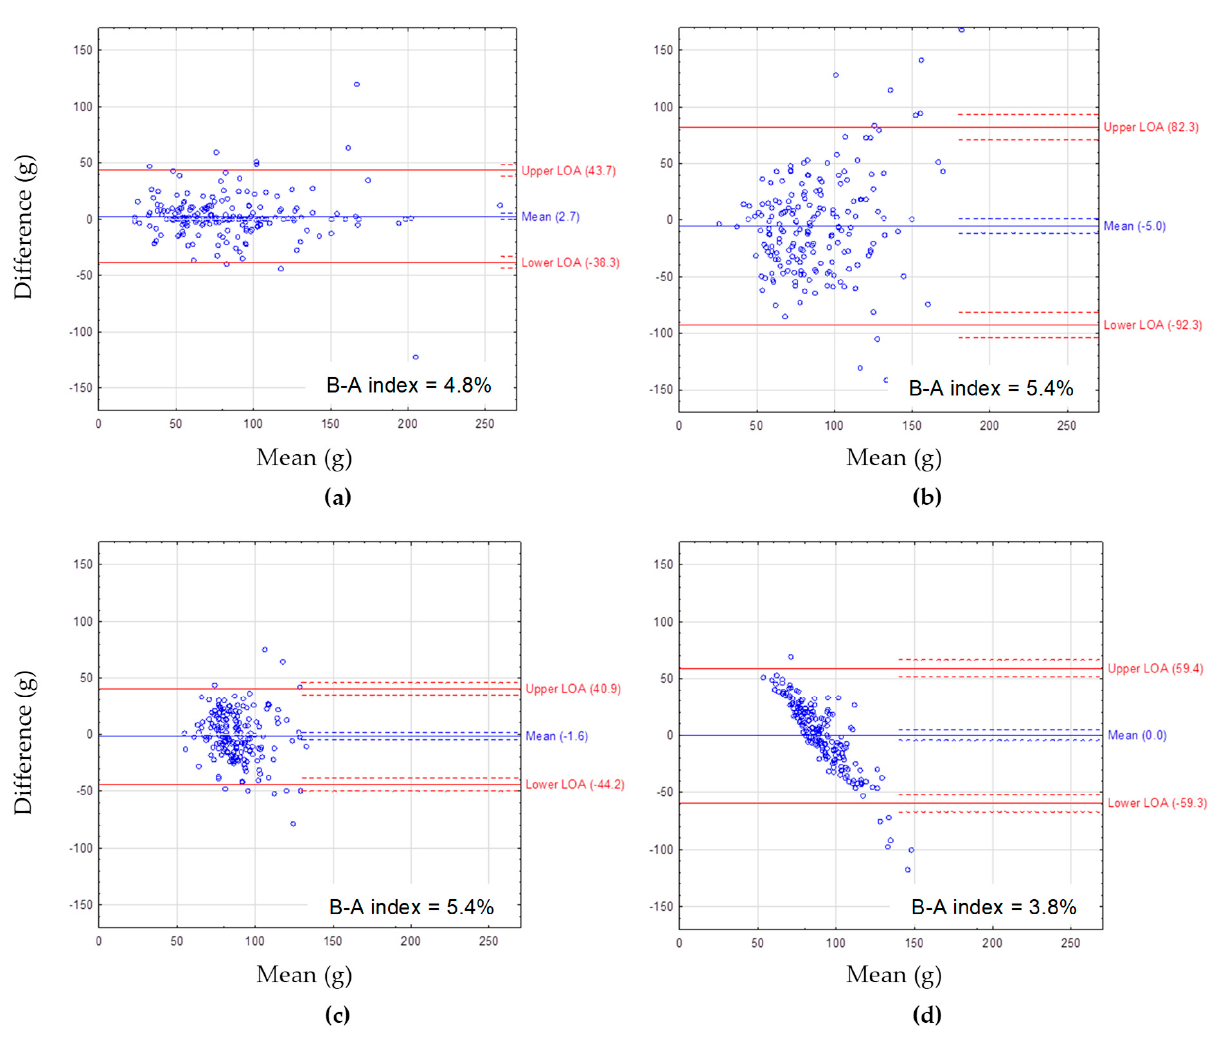
Figure 1. The Bland–Altman plots for protein intake assessed with: ( a ) FFQcrude and FFQretest, ( b ) FFQcrude and FRcrude, ( c ) FFQstand and FRstand, ( d ) FFQreg and FRcrude. FFQcrude—crude data from the first administration of the FFQ (test), FFQretest—crude data from the second administration of the FFQ, FRcrude—crude data from the 2-day estimated food record (FR), FRstand—the FR data after standardization of energy intake, FFQstand—the FFQ data after standardization of energy intake, FFQreg—the FFQ data adjusted by regression. Mean—mean difference in protein intake between the methods (blue solid line) with 95% CI (dashed lines). LOA—95% limits of agreement between the methods (red solid lines) with 95% CI (dashed lines). B-A index—the Bland–Altman index calculated as percentage of respondents beyond LOA.